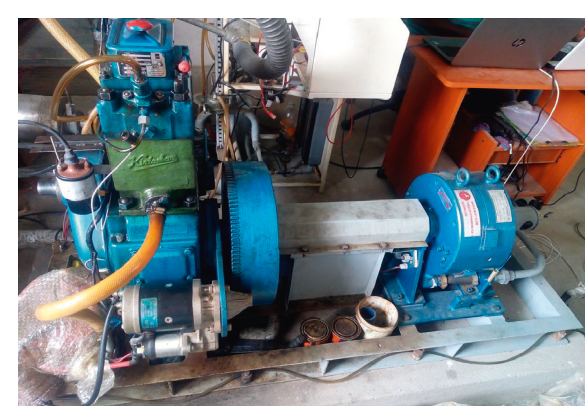
Figure 1: Engine setup with common rail injection